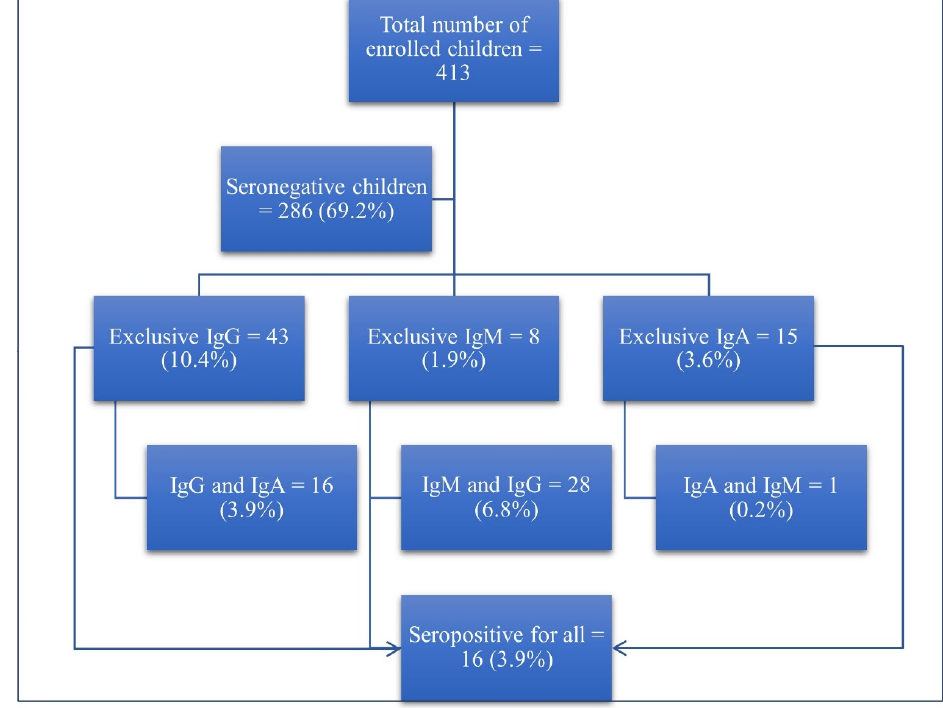
Figure 1. Flowchart of the seroprevalence among the study population.